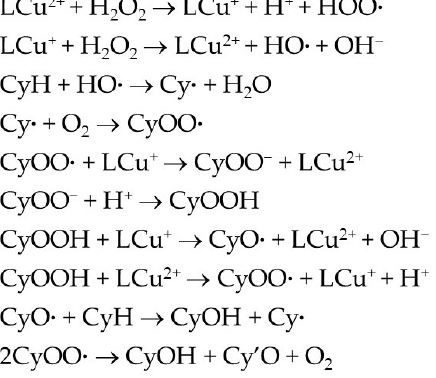
Scheme 4. Simplified mechanism for the Cu-catalyzed oxidation of cyclohexane (CyH) by H 2 O 2 to cyclohexyl hydroperoxide, cyclohexanol and